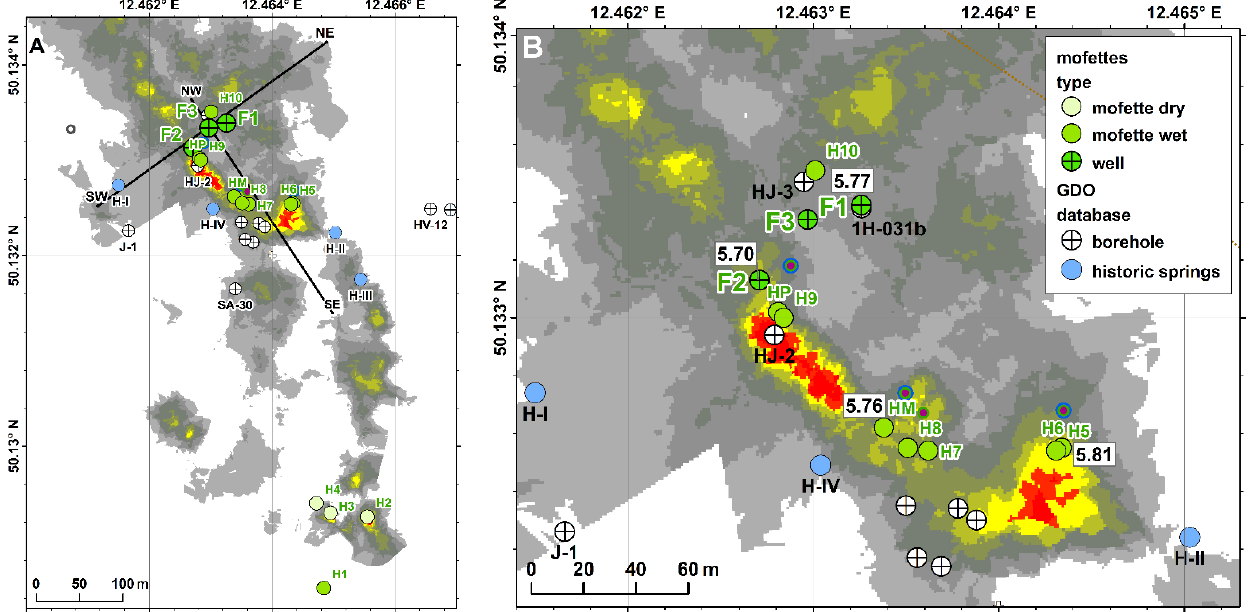
Figure 3. Map of the Hartoušov mofette system showing CO 2 flux distribution (from Nickschick et al. [15], light gray colors indicate a CO 2 flux above 25 g/d/m 2 ; red colors mark regions with a CO 2 flux >50 kg/d/m 2 ), the location of the ICDP research boreholes (F1, F2, and F3), wet and dry mofettes according to [12], historic springs, boreholes (the latter two from GDO (geologically documented objects) database of the Czech Geological Survey), and shallow drillholes (from [27]). ( A ) Position of SW–NE and NW–SE profiles used for the stratigraphic and hydrogeological profiles shown in Figure 4. ( B ) Numbers in boxes indicate air-corrected helium isotope ratios ( 3 He/ 4 He) c in R A units from Daskalopoulou et al. [22].